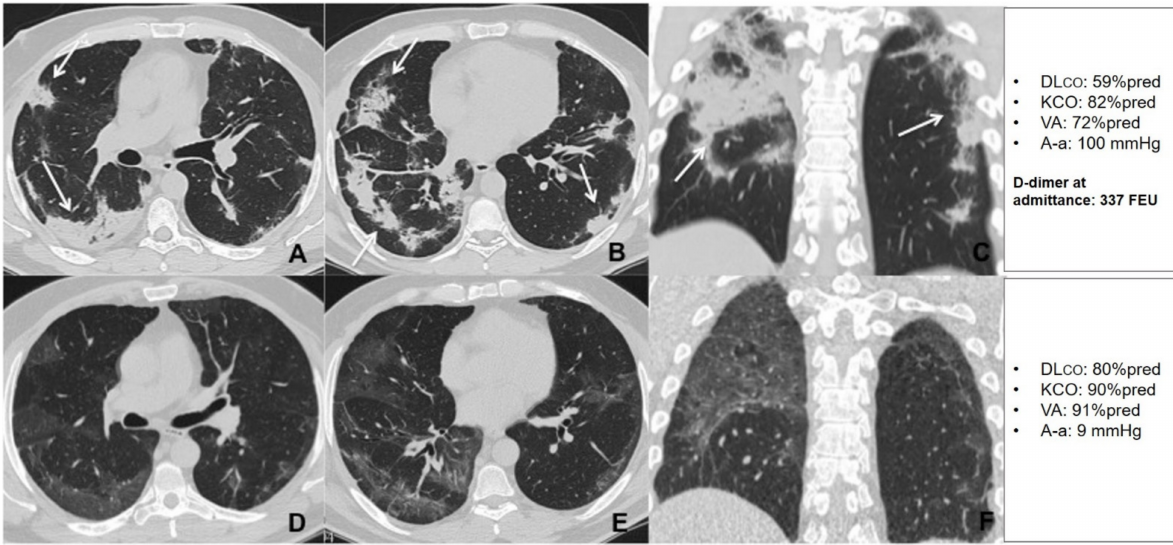
Figure 7. Unenhanced thin section axial ( A , B ) and coronal ( C ) CT images of the lungs obtained the 10th day post-admission in a 51-year-old man with no previous exposure to cigarette smoke, no cormorbidities, that was admitted to the high dependency respiratory care unit (HDRU) with severe respiratory failure (PaO 2 /FiO 2 182 mmHg) and treated with continuous positive airway pressure (CPAP) for 10 days. The images show peripheral consolidations (arrows) in both lungs, with predilection for posterior areas. Unenhanced thin section axial ( D , E ) and coronal ( F ) CT images of the same patient 6 weeks post-discharge show bilateral peripheral GGO with resolution of previous consolidations. The patient had a low D-dimer at admission and showed a significant improvement in his DLco during the recovery